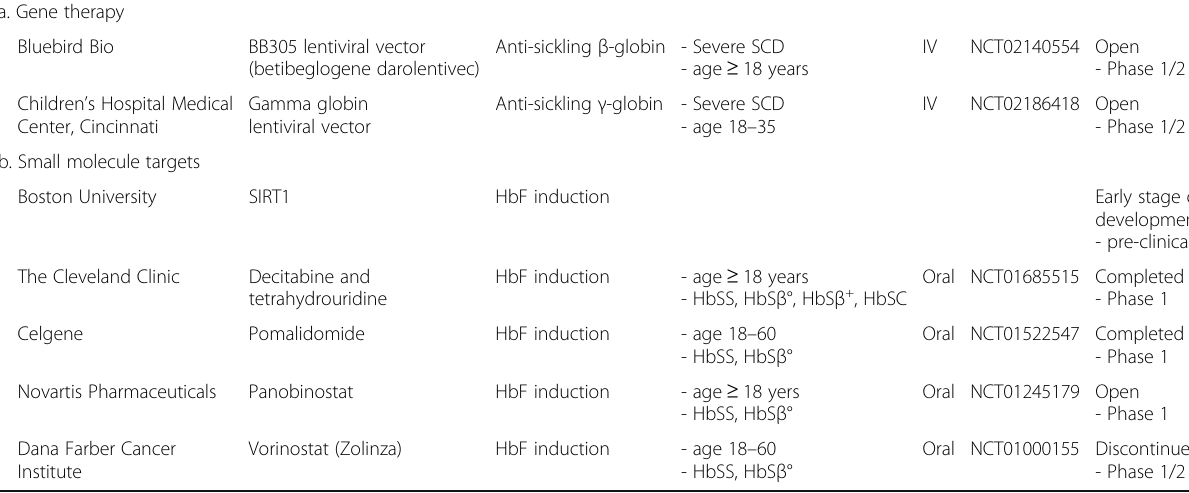
Table 1 Novel therapeutics in Sickle Cell Disease a. Gene therapy Bluebird